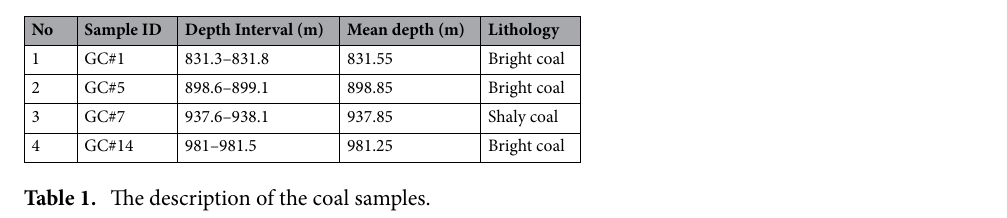
Table 1. The description of the coal